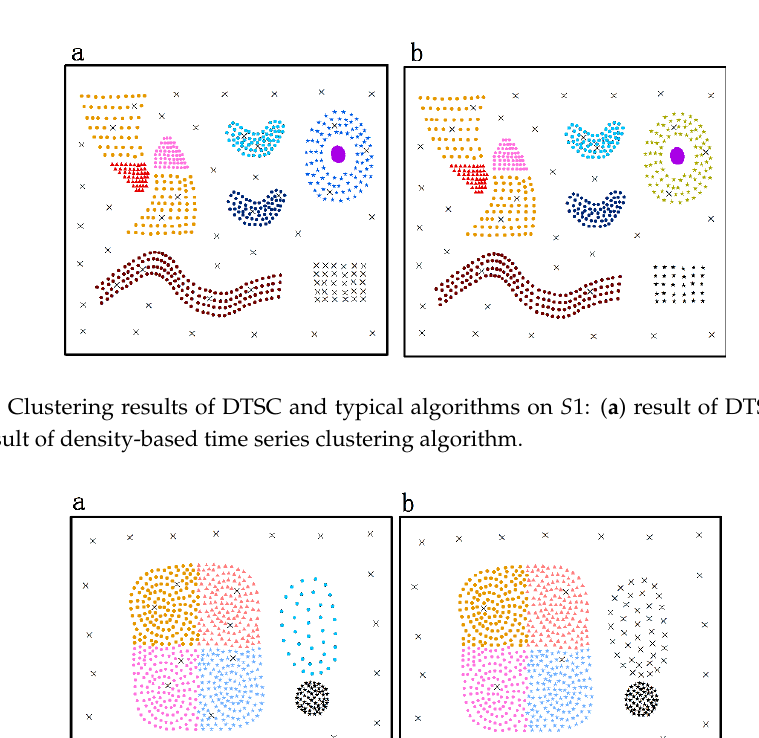
Figure 11. Clustering results of DTSC and typical algorithms on 𝑆2 : ( a ) result of DTSC algorithm; and ( b ) result of density-based time series clustering algorithm. Table 1. Accuracy values of clustering results on simulated datasets and its corresponding computation cost time.